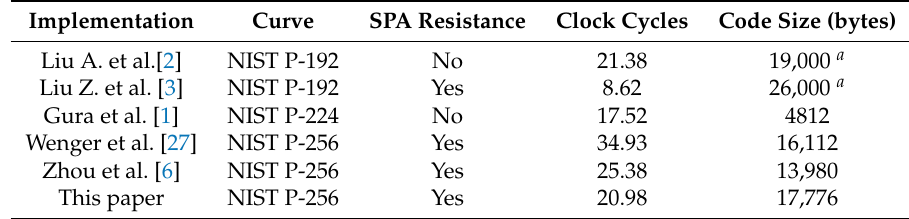
Table 3. A comparison of various implementations of scalar multiplication over NIST curves